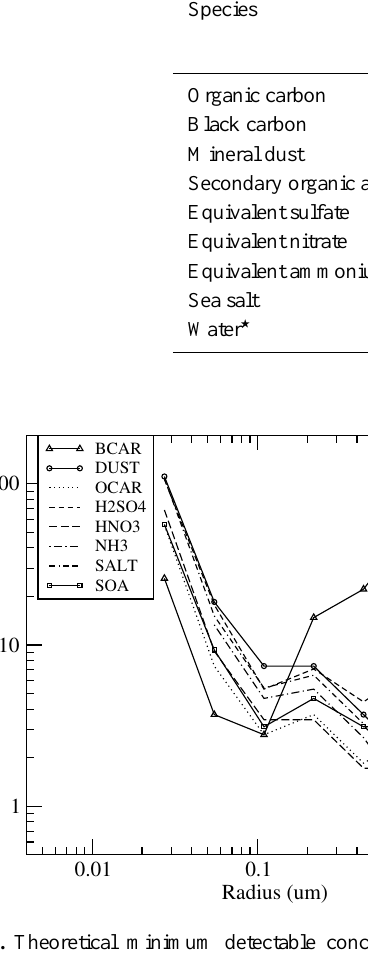
Fig. 8. Theoretical minimum detectable concentration (µgm − 3 ) per size section corresponding to R 0 ≥ 1 . 2 (CALIOP night-time threshold) for each of the aerosol species considered by the model. Concentrations are considered at altitudes between ∼ 700 and ∼ 1200m .